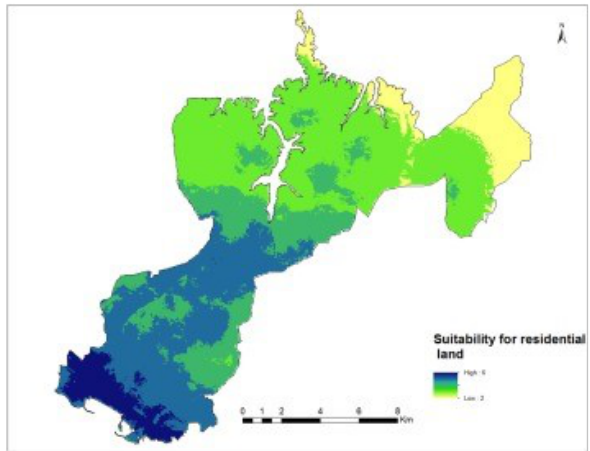
Figure 5. Residential land suitability for Pendik/Istanbul